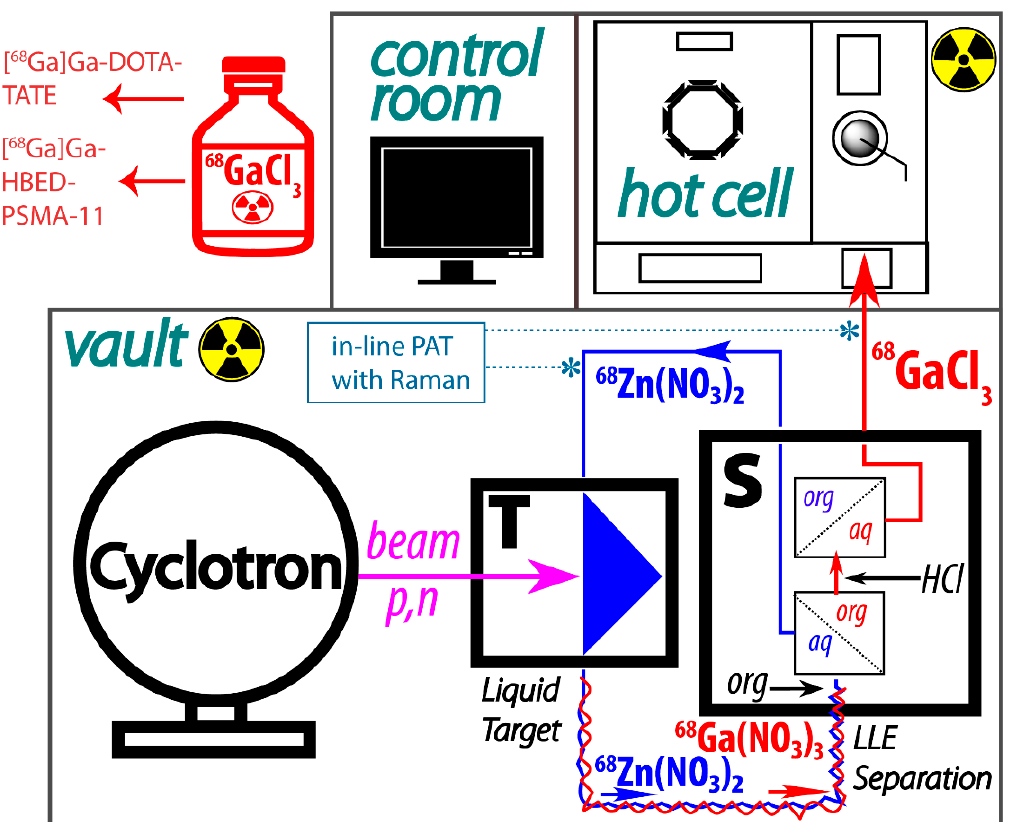
Figure 1. Conceptual schematic of the continuous production of 68 Ga using a cyclotron solution target ( T ). Phase separation is performed in module S using a membrane separator; the 68 Ga is back-extracted from the organic phase with 0.1 M HCl and is sent directly into the hot cell. The organic phase is discarded.